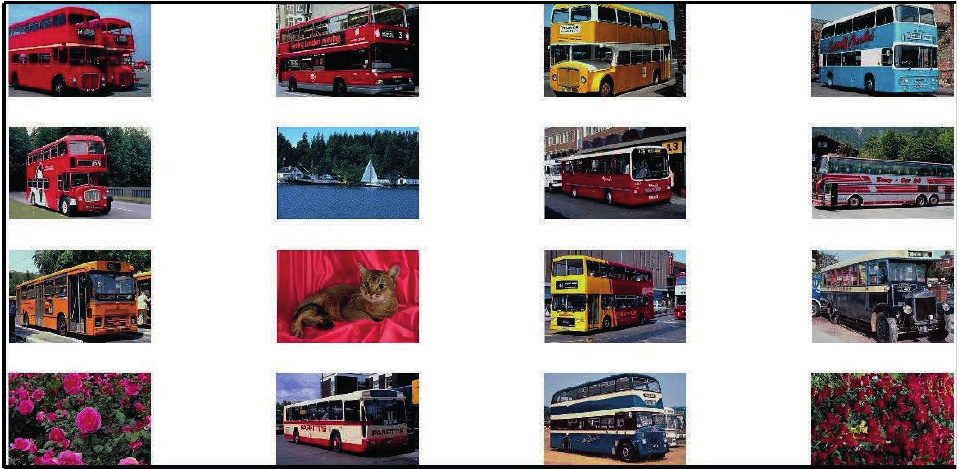
Fig. 21. Bus images retrieved using Framework-2